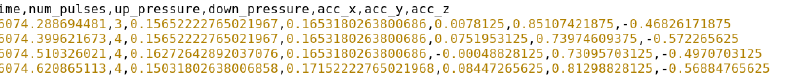
Figure 35. Example of a comma-separated values (CSV) file used to record the data collected from the